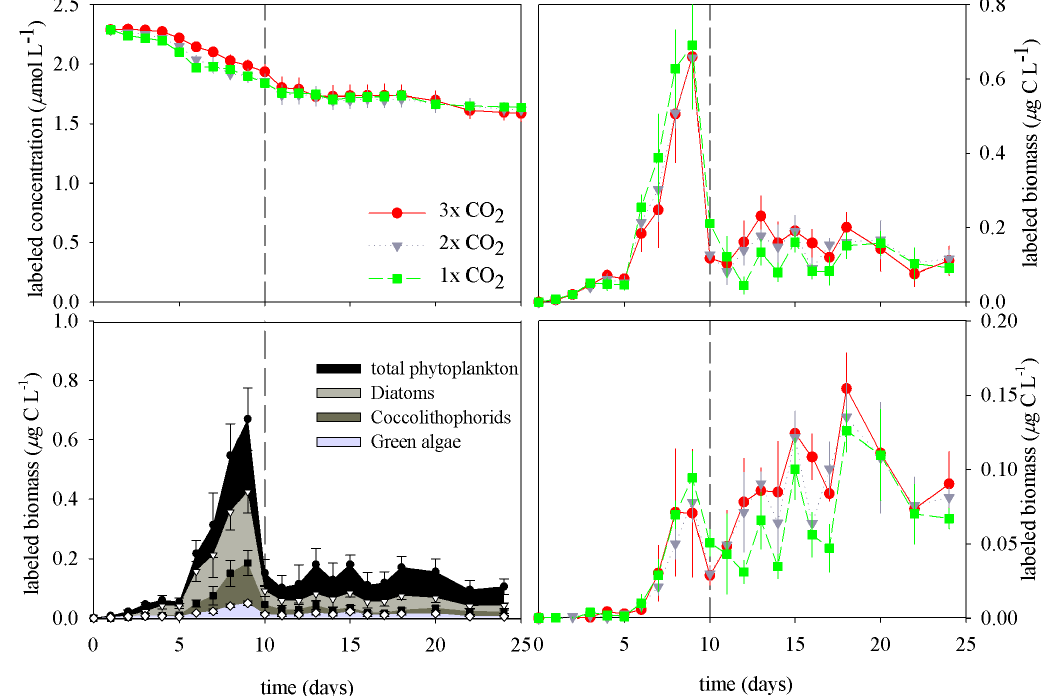
Fig. 4. Concentrations of 13 C labelled (A) DIC, (B) phytoplankton, phytoplankton groups (C) , and (D) bacteria. Average and SD of the three replicates are shown for (A–C) and average and SD of all mesocosm data are shown in